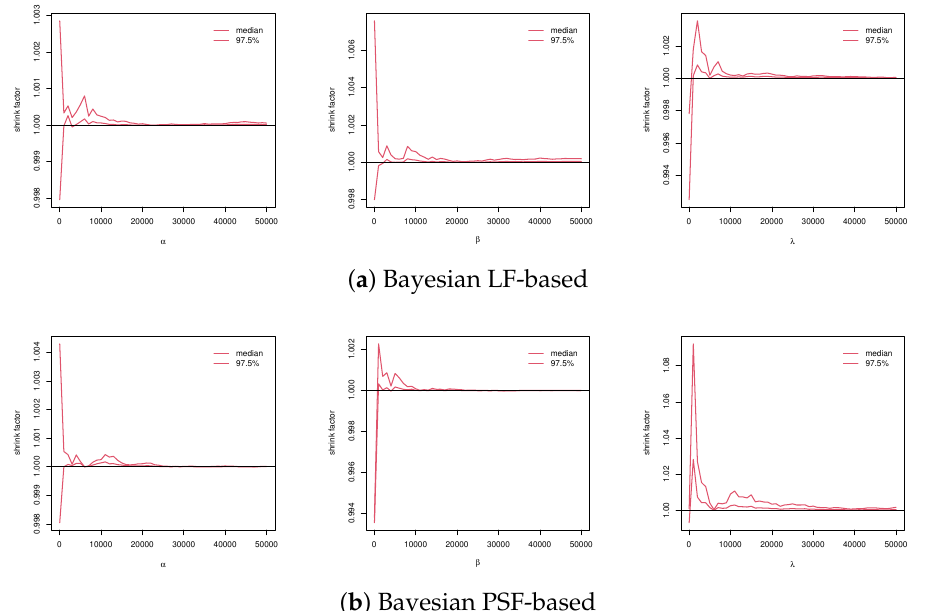
Figure 14. The BGR diagnostic for MCMC draws of α , β , and λ from LED